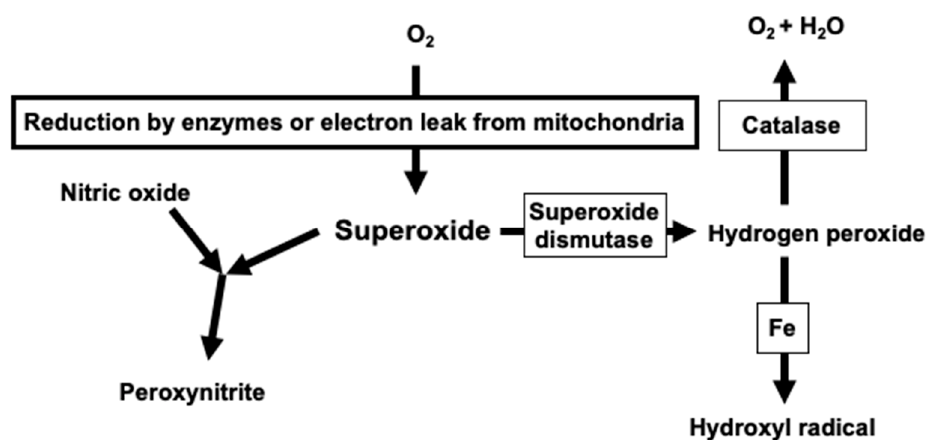
Figure 1. Superoxide and the reactive oxygen species derived from it in human vascular pathology are shown. Superoxide is a critical precursor of reactive oxygen species, including hydrogen peroxide, hydroxyl radical, and peroxynitrite. Superoxide dismutase metabolizes superoxide to hydrogen peroxide, whereas catalase inactivates hydrogen peroxide.